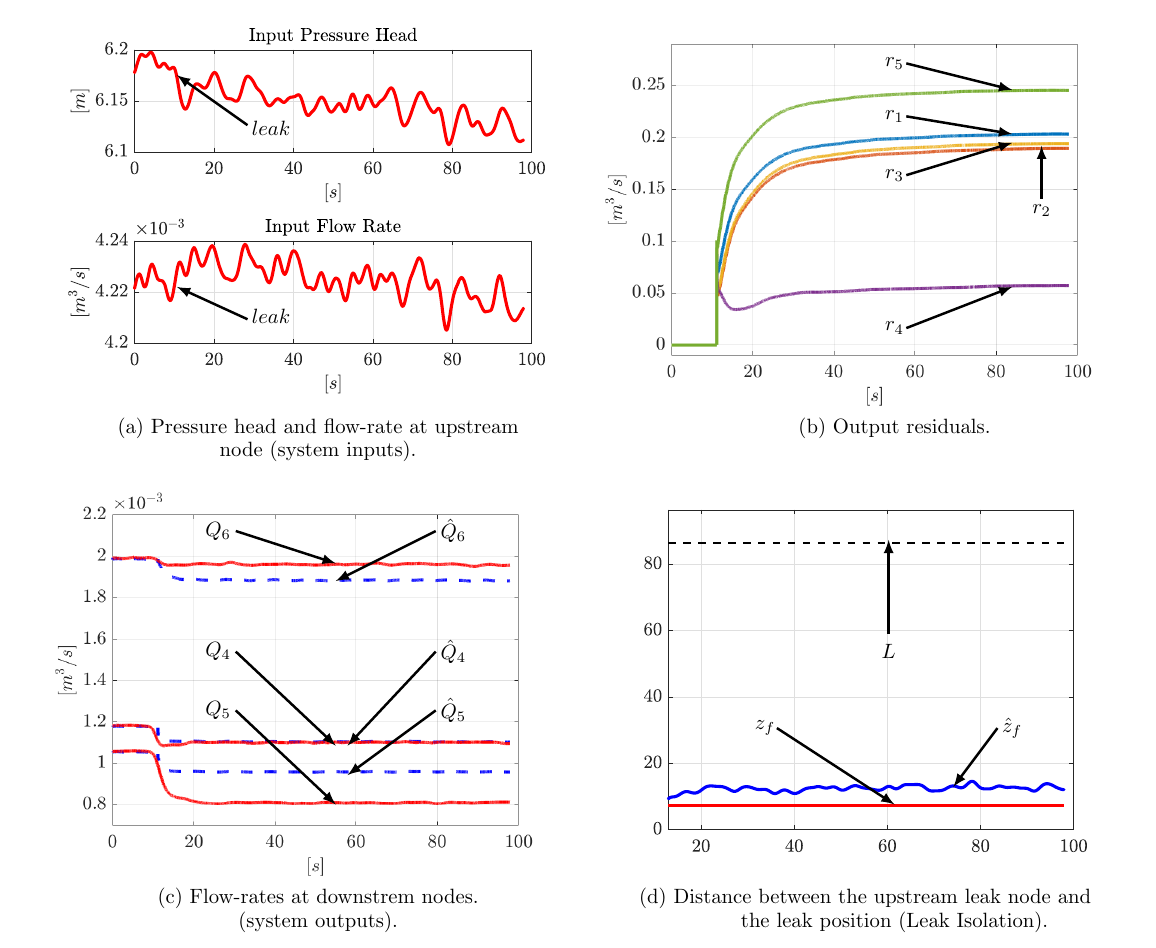
Figure 15. Experiment 4: leak induced in valve 4: ( a ) Pressure head and flow rate at upstream, ( b ) Output residuals, ( c ) Flow rate at downstream nodes and, ( d ) Leak